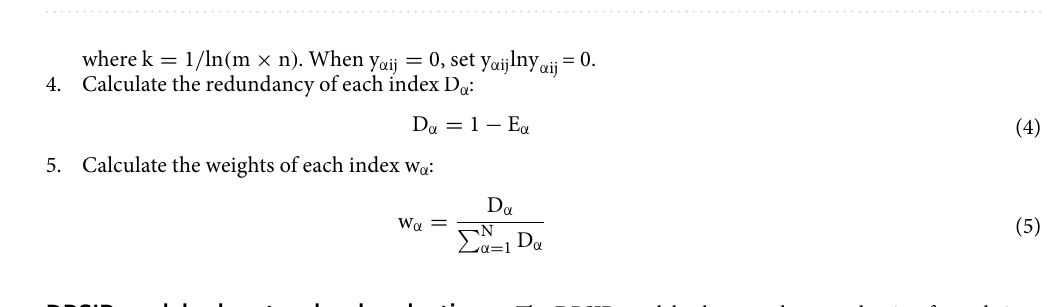
Figure 2. The research areas of the Yellow River